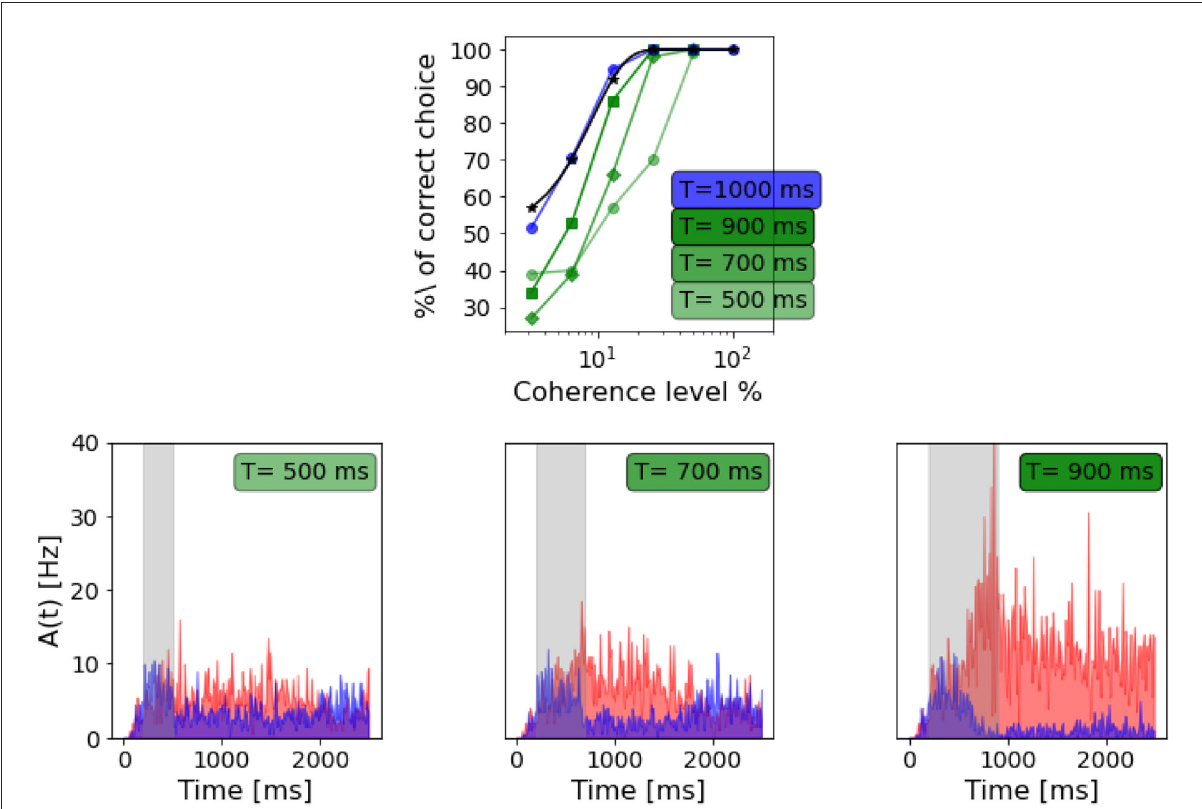
FIGURE8 Dependency on stimulus duration: Top panel: neurometric function for different stimulus duration compared to the weibull fit as reported by Wang (2002) (black curve). Bottom panels: population A and population B firing rate activity in three different trials, but same coherence level (-12.8%). From the left: stimulus delivered for 500 ms, stimulus delivered for 700 ms, stimulus delivered for 900